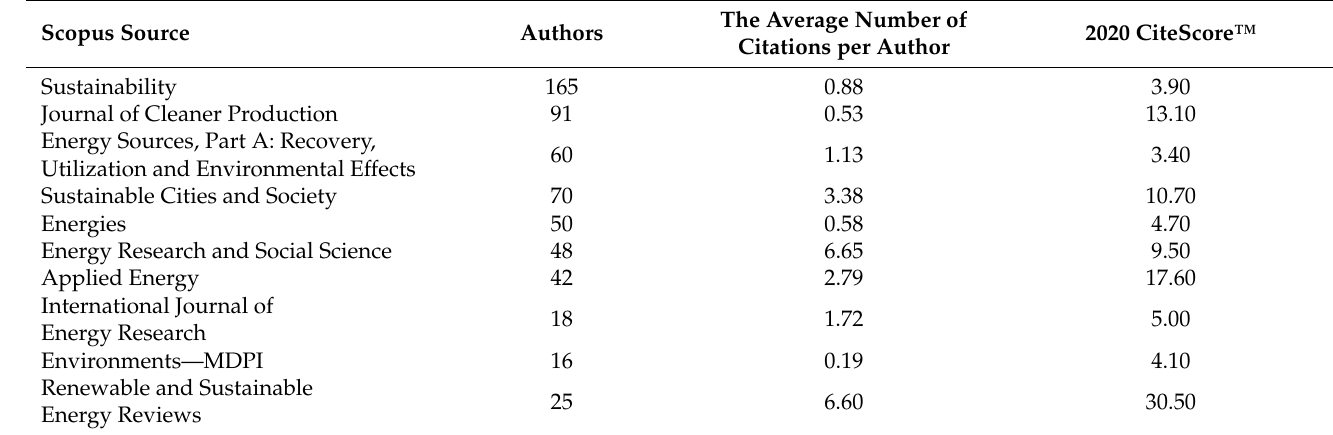
Table 2. Scholarly output by Scopus source within energy (subject area: renewable energy, sustain- ability, and the environment),